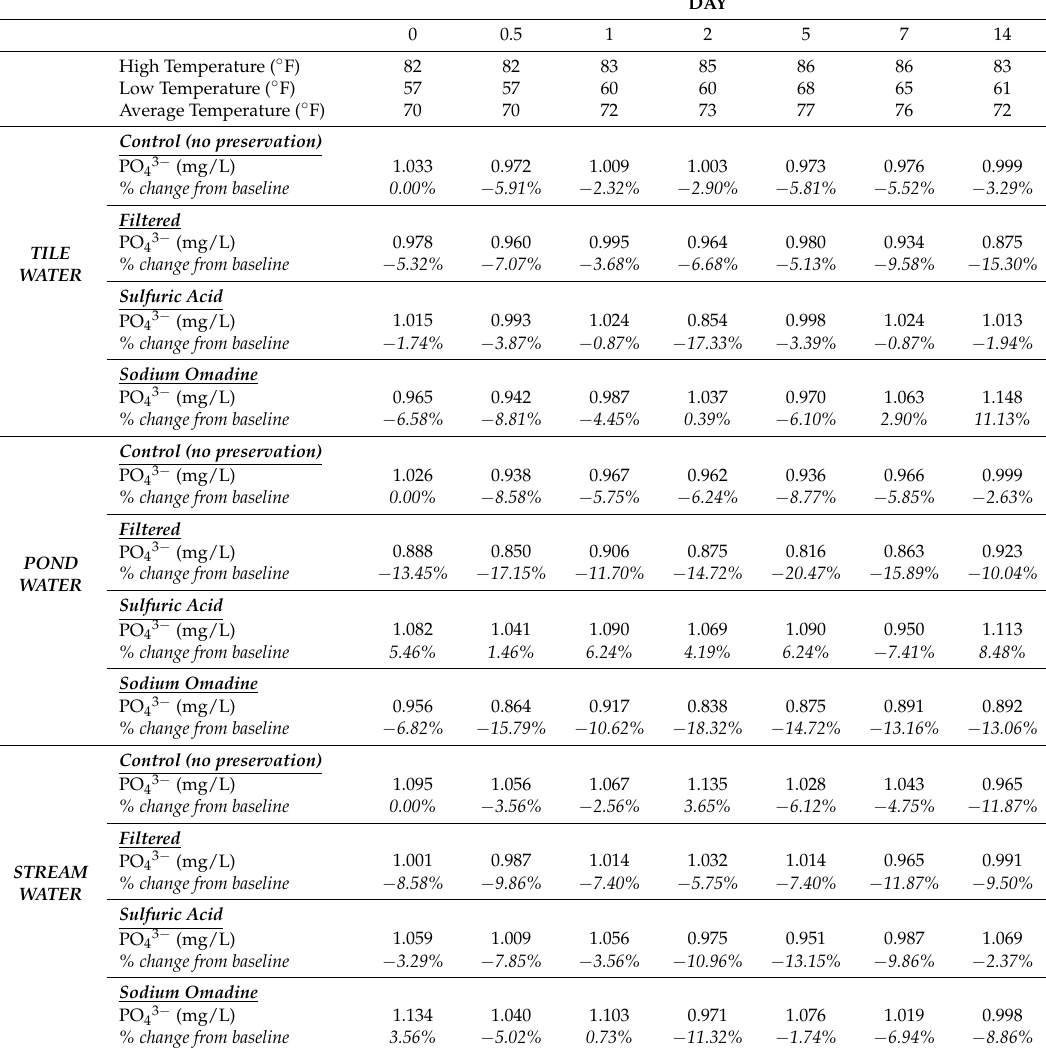
Table 5. Daily high and low temperature that water samples were exposed to, as well as the orthophosphate concentrations and % change from the baseline concentration. The baseline concentration is the Day 0 Control for each water